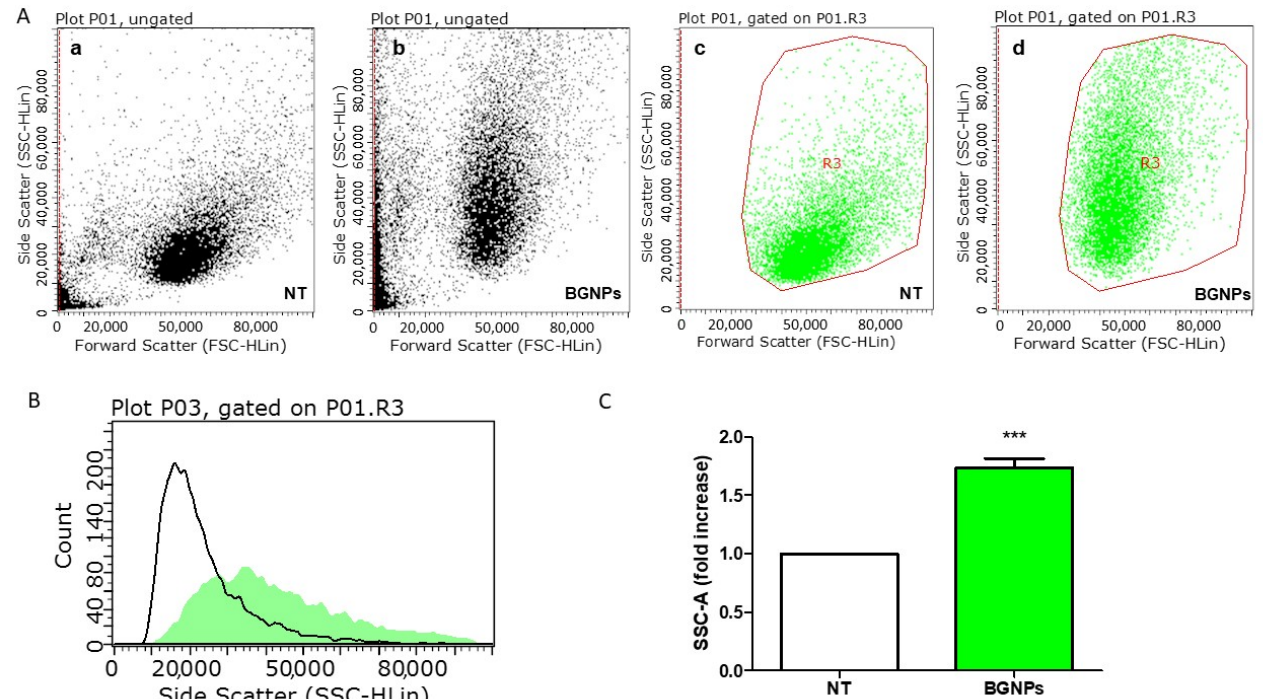
Figure 3. Flow-cytometric analysis of DLD1 after 24 h of BGNP exposure. ( A ) Representative gating plot of side scattering (SSC-A) versus forward scattering (FCS-A) of non-treated (NT) cells and BGNP-treated cells with all acquired events ( a , b ) and gated on living cells (R3) ( c , d ); ( B ) representative overlay of a side scattering histogram of cells exposed to BGNP compared to NT cells (dark line); ( C ) median relative fold-increase of SSC compared to NT cells of four independent experiments. *** p < 0.001 versus NT cells.